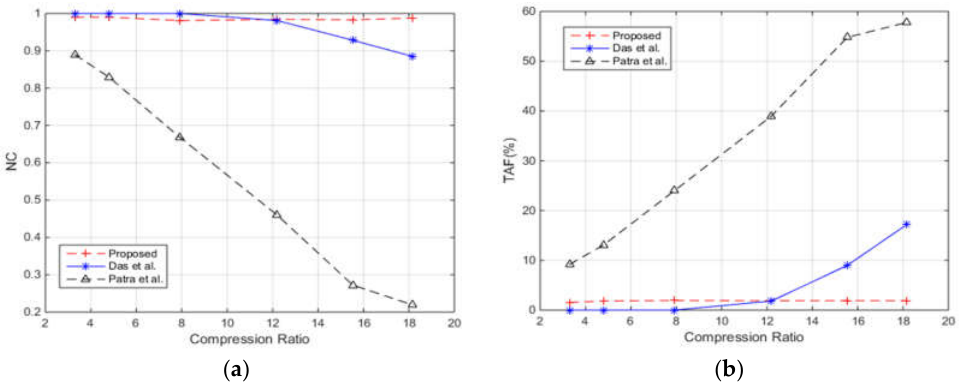
Figure 4. Performance of compression attack on Lena image on ( a ) NC vs. Compression ratio; and ( b ) TAF vs. Compression ratio. Future Internet 2017 , 9 , 33